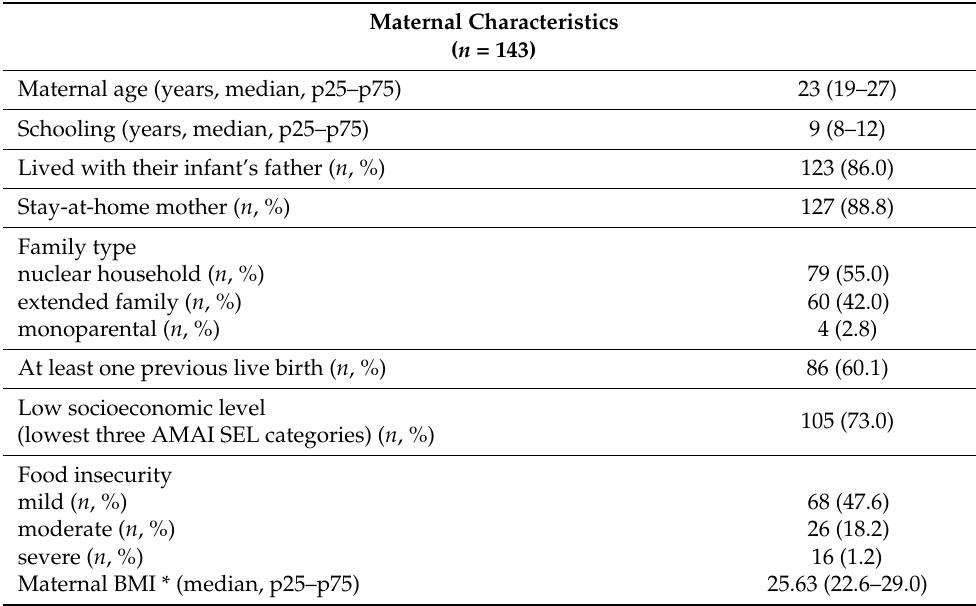
Table 1. Maternal and infant